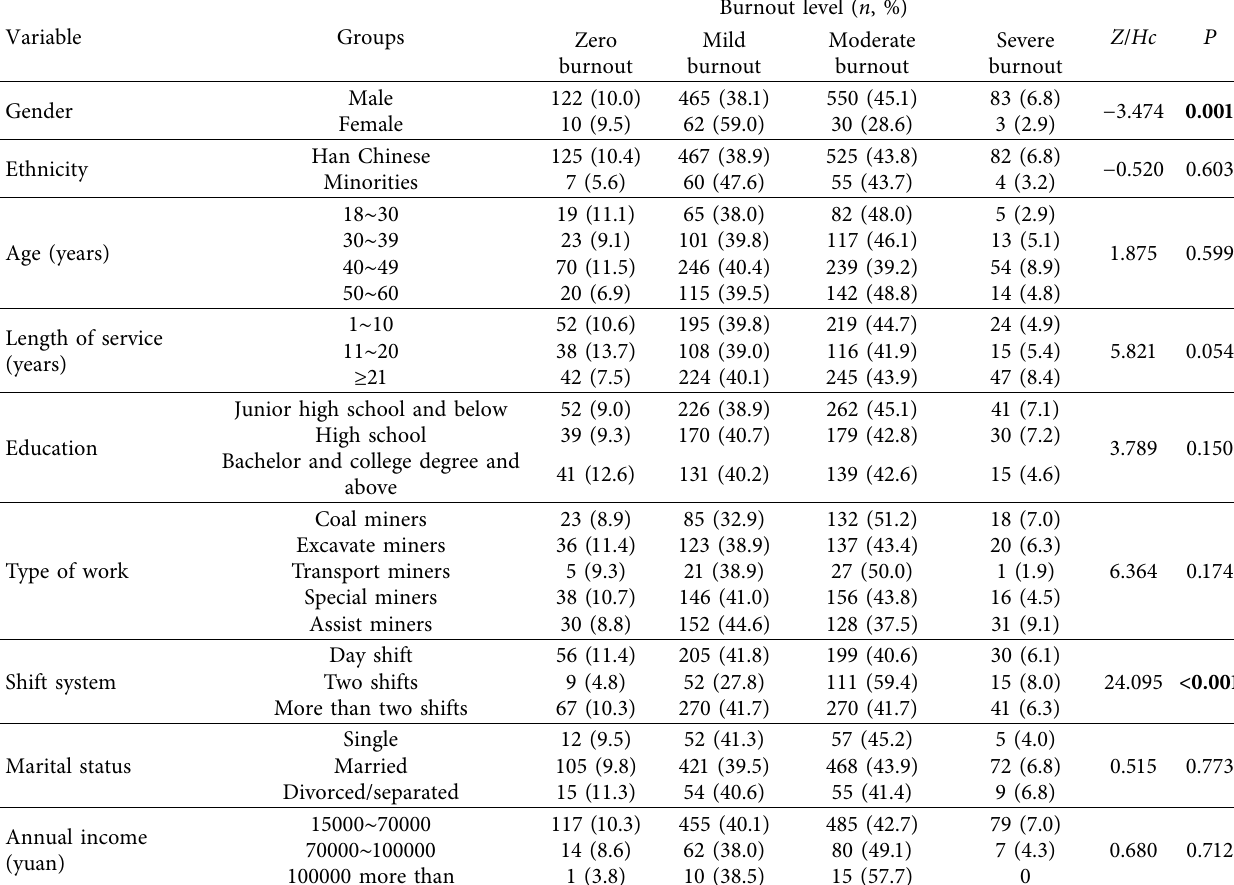
Table 2: Comparison of job burnout grades with different demographic characteristics.